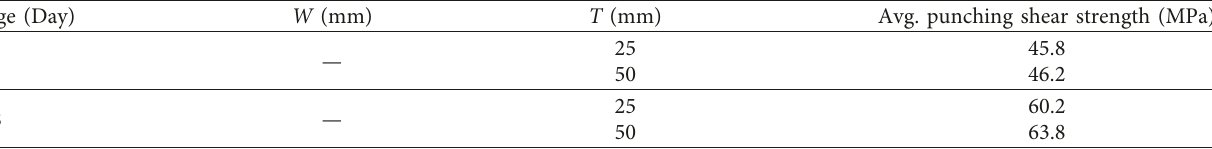
Table 7: Punching shear outcome of nonrestrained.